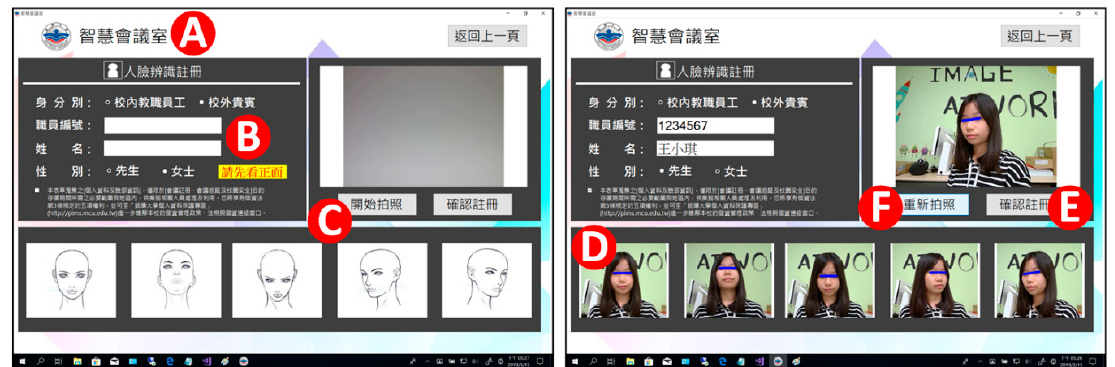
Figure 14. The face registration screen of an in-campus facial recognition cloud service. Portion A is the title of the screen which means ‘Smart Meeting Room’. This screen is for users to register their face for facial recognition applications. In portion B, users need to enter user information, such as user